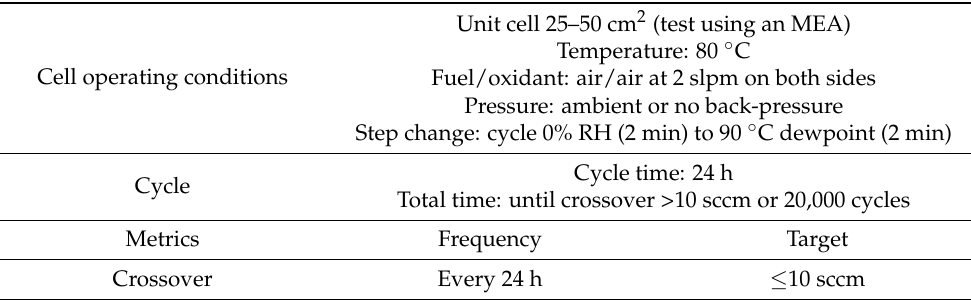
Table 1. DOE AST protocol for MEA mechanical degradation